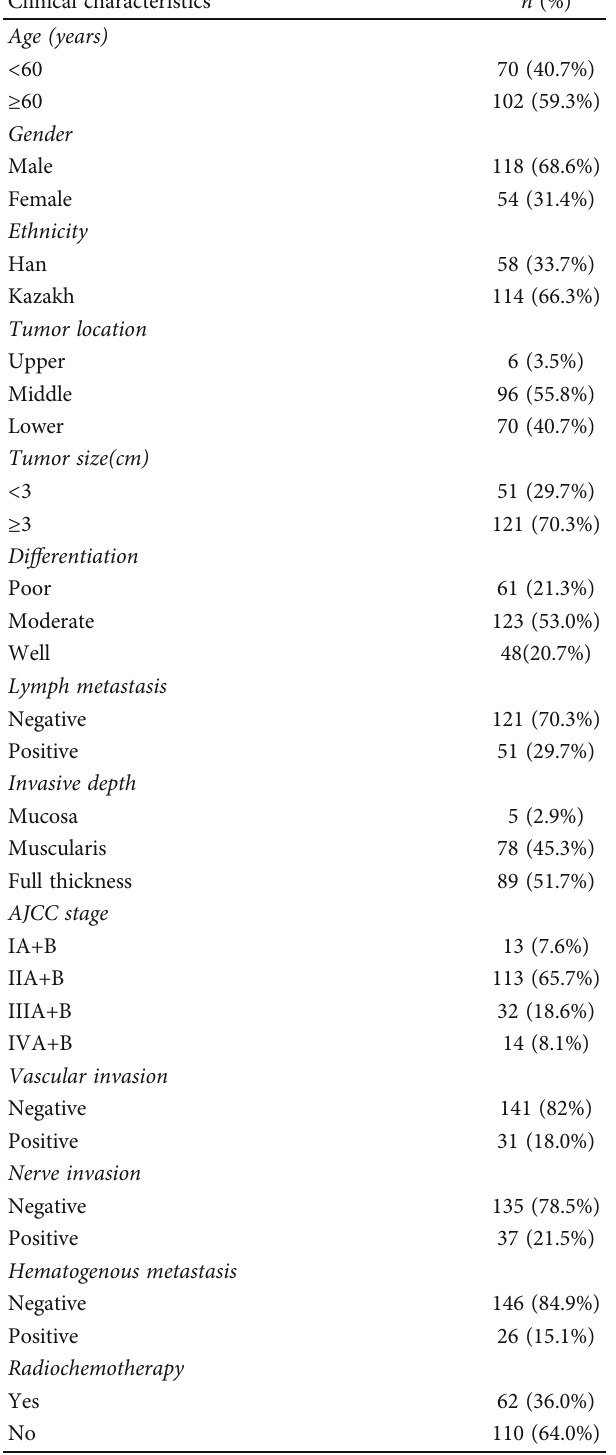
Table 1: General characteristics of ESCC patients. Clinical